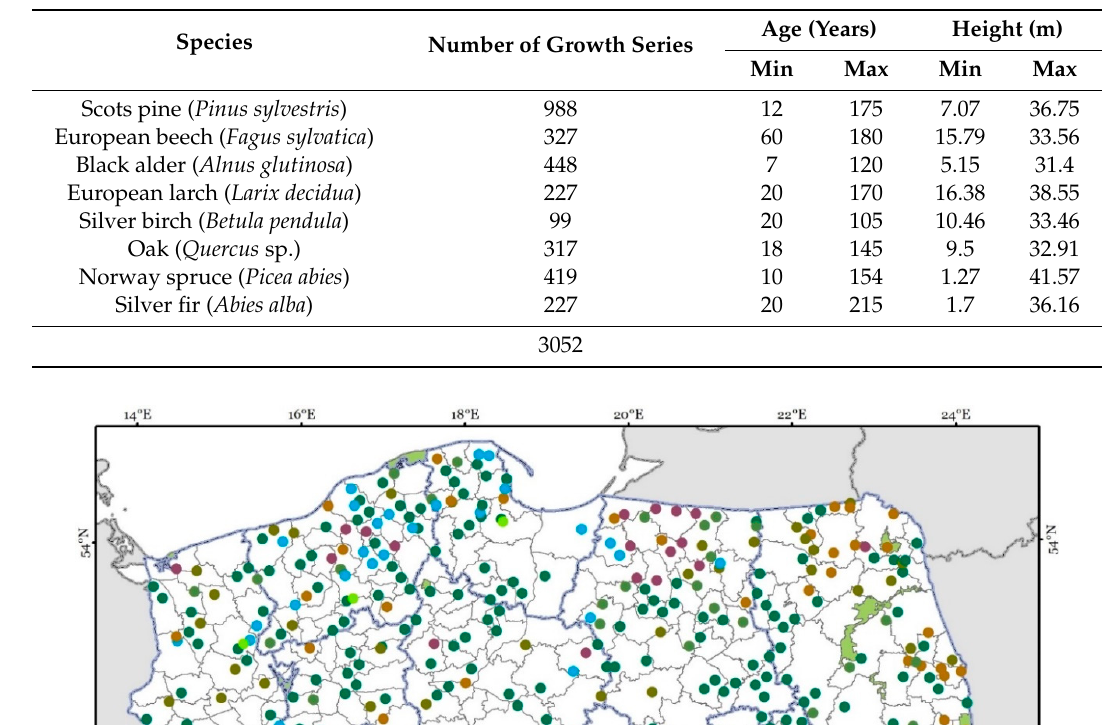
Table 1. The number and basic characteristics of growth series for the analyzed species, obtained from stem analysis and used for the development of the site index models.